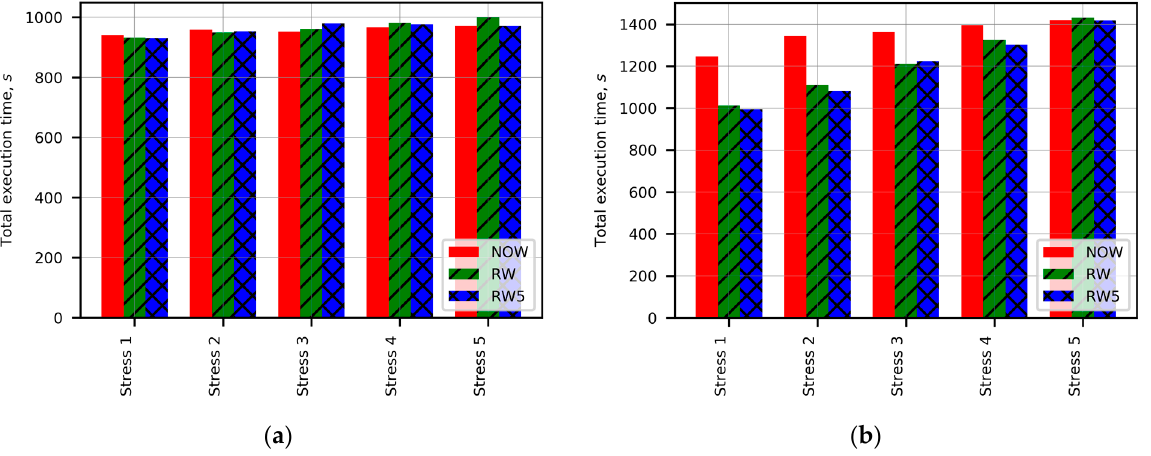
Figure 5. Total execution times of DEM SaaS on co-located resources: ( a ) benchmark co-located with the CPU stress test in Case 4; ( b ) benchmark co-located with the memory stress test in Case 5.